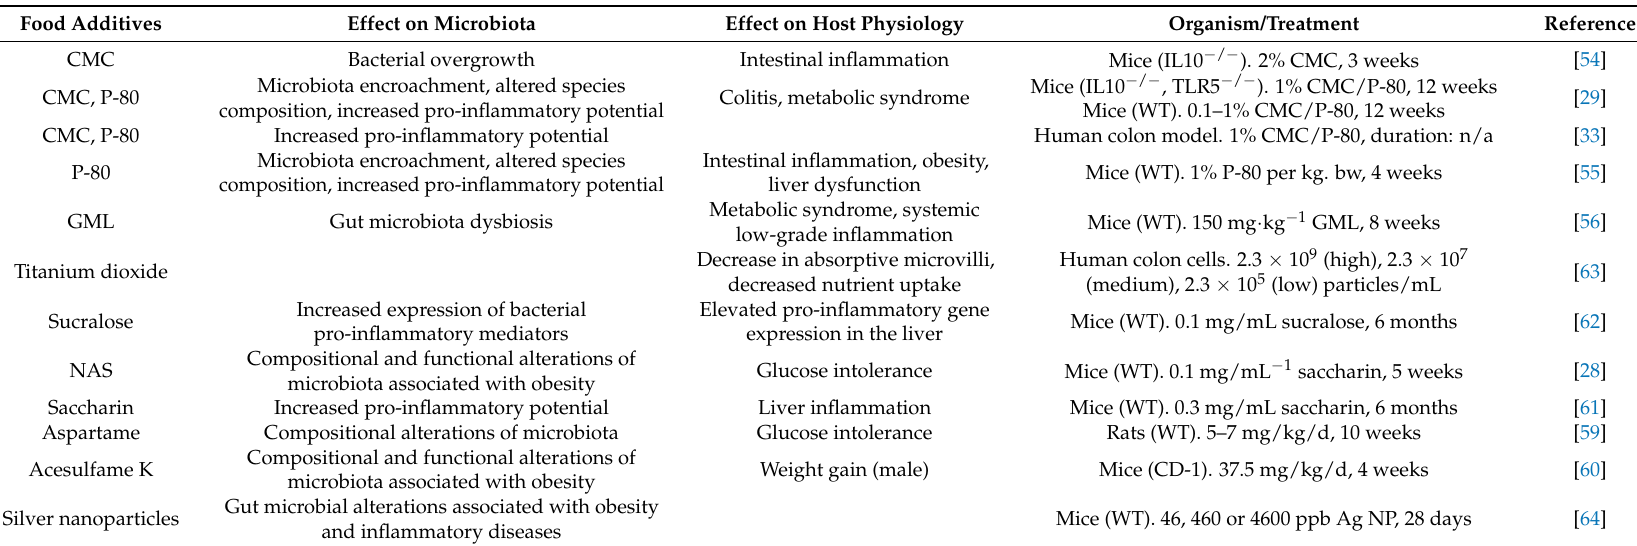
Table 1. Components of a Western diet and effects on the microbiota and/or host physiology. This is not an exhaustive list. Examples are chosen based on a crude assessment of relevance to issues discussed in this paper (dosages administered are below or correspond to ADI levels, or are meant to mimic estimated intake levels in